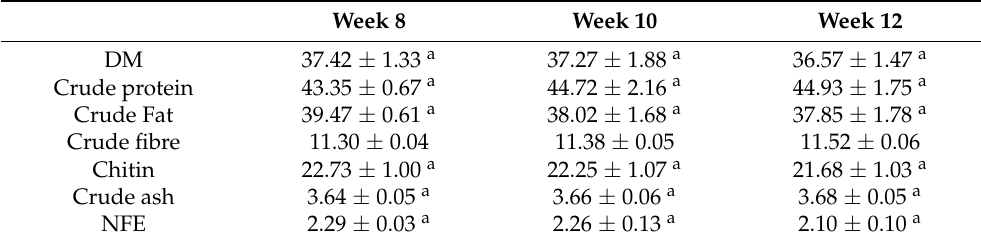
Means in the same row with different superscripts differ significantly ( p <